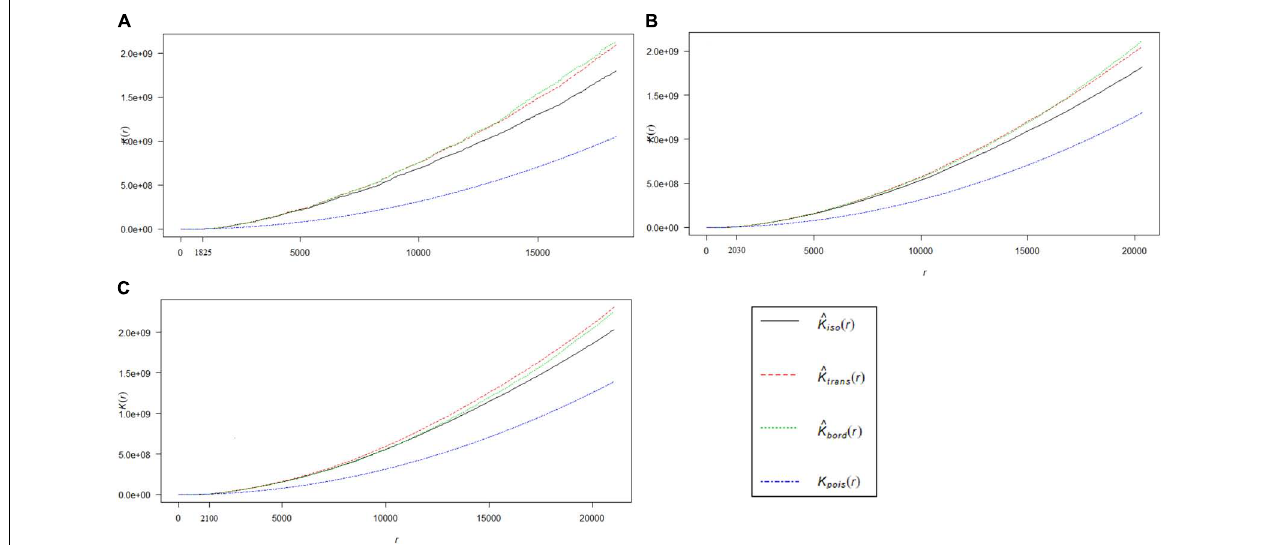
FIGURE 3 | The graph represents the result of inferential analysis of K-function, which is statistically deviating from complete spatial randomness. Distribution of the true values of K [Kpois (r)] for HEC1 (A) , HEC2 (B), and HEC3 (C) incidences (blue line), which is compared to their corresponding expected values [Kiso (r) in black line, Ktrans (r) in red line and Kbord (r) in green line]. HEC incidences are clustered at distances greater than 1.825 km, 2.03 and 2.1 km for HEC1, HEC2, and HEC3 respectively. Note: The isotropic, translate and border corrections are executed by default in the K-function of